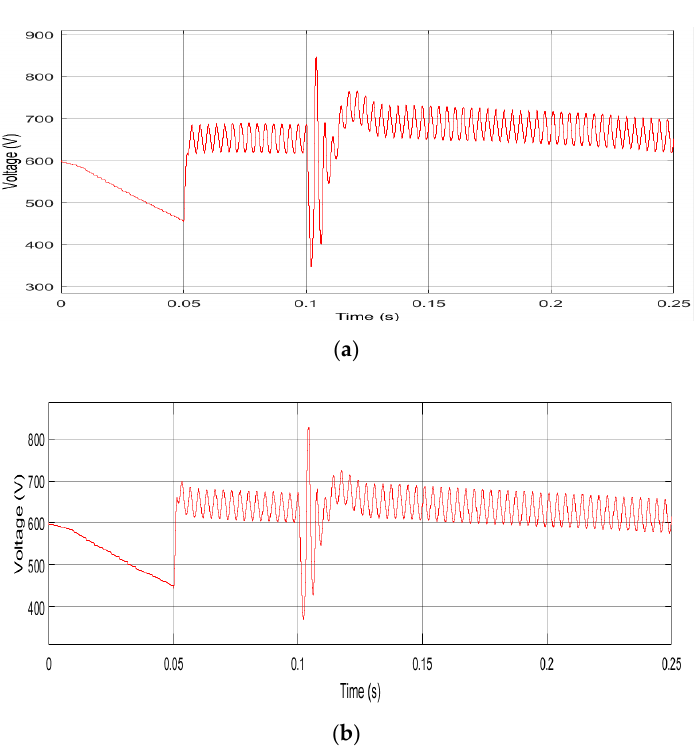
Figure 10. DC-link bus voltage waveform: ( a ) DC-link bus voltage waveform based on standard PSO algorithm. ( b ) DC-link bus voltage waveform based on CPSO-MAS